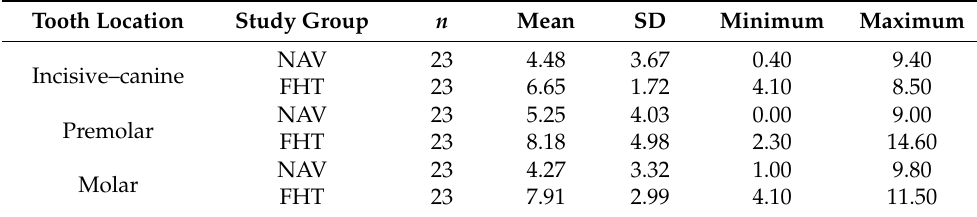
Table 6. Descriptive deviation values at angular level ( ◦ ) of the orthodontic micro-screws placed